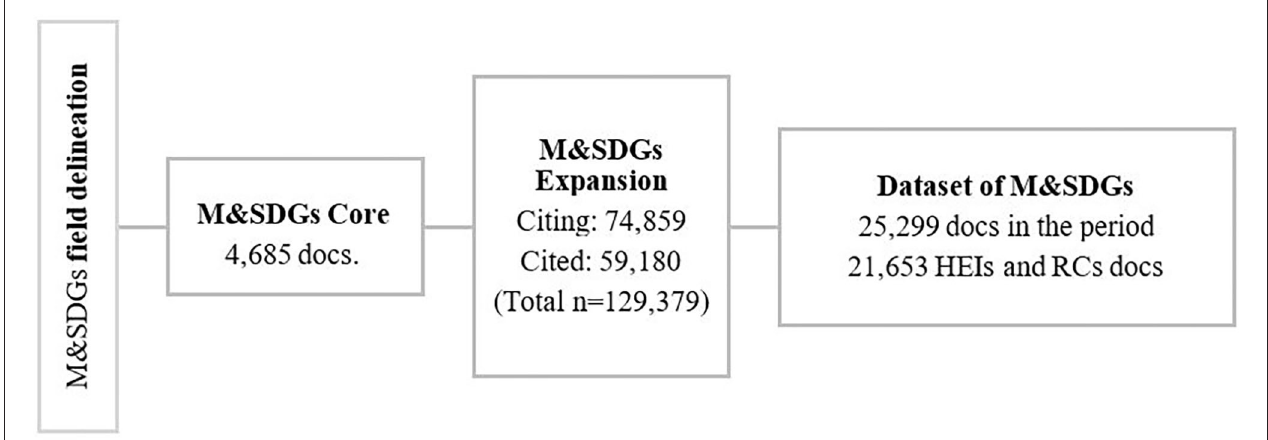
FIGURE 1 | Methodological workflow for delineating M&SDGs on this study and creating the final dataset.